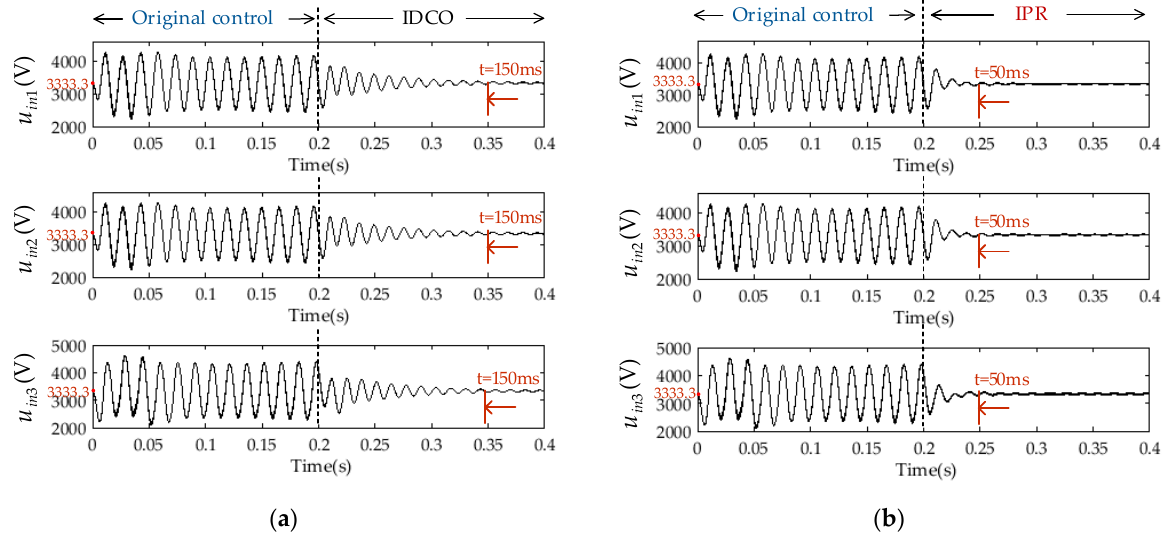
Figure 18. Input voltage of three DAB modules: ( a ) IDCO method, ( b ) proposed IPR method. In the observation from Figure 18a,b, the DAB modules voltage u in 1 , u in 2 , and u in 3 are stable at 3333.3 V. The simulation results demonstrate that the ISOP DCT achieves input voltage sharing. It indicates that the input voltage sharing controller optimization could be ignored, which is consistent with Figure 10. In addition, the transient period of the proposed IPR method is 100 ms shorter than that of the IDCO method. These results indicate that the proposed method can stabilize the voltage faster.